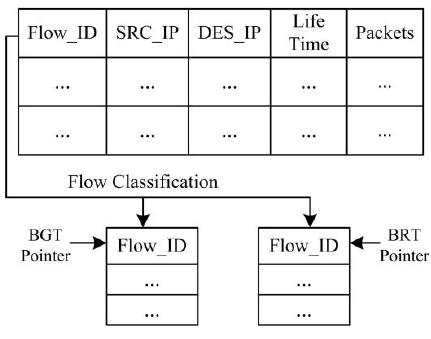
Figure 7. The global-view flow table.